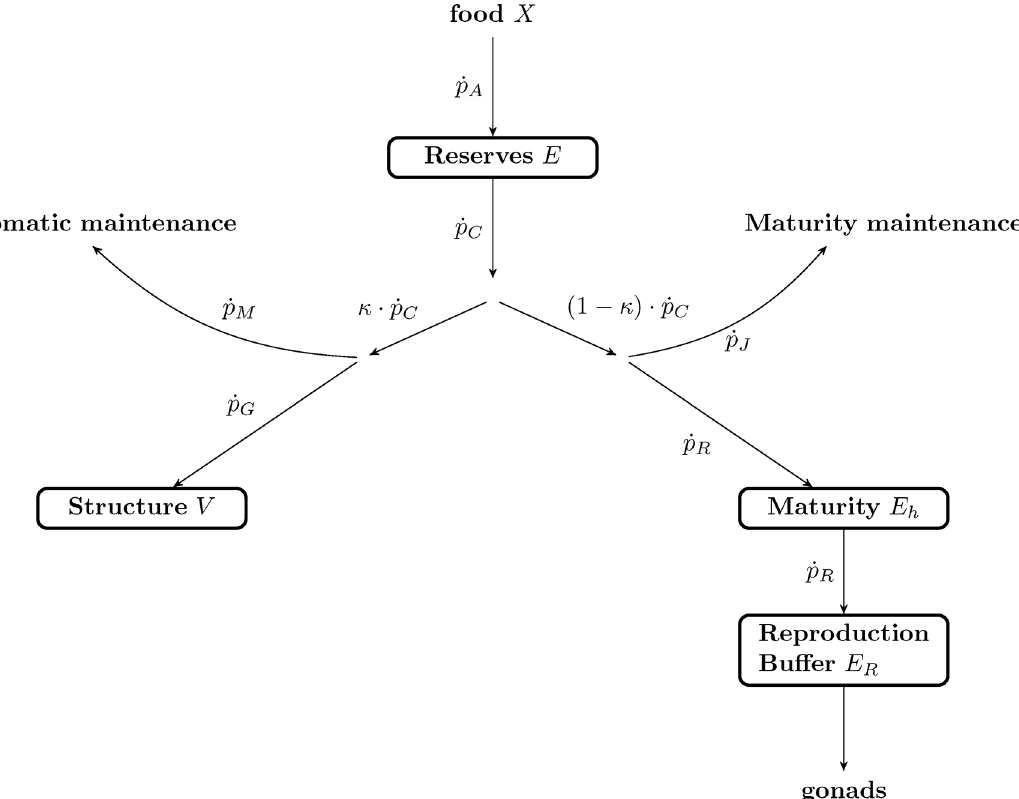
Fig 1. Schematic representation of the standard DEB model [18]. Arrows represent energy fluxes (J d -1 ) that drive the dynamics of the four state variables (boxes). Energy enters the organism as food ( X ), is assimilated at a rate of p _ leaving the reserve to cover somatic maintenance ( p _ ) (mature individuals). κ is the proportion of the mobilized energy diverted to p _ reproduction ( p _ R